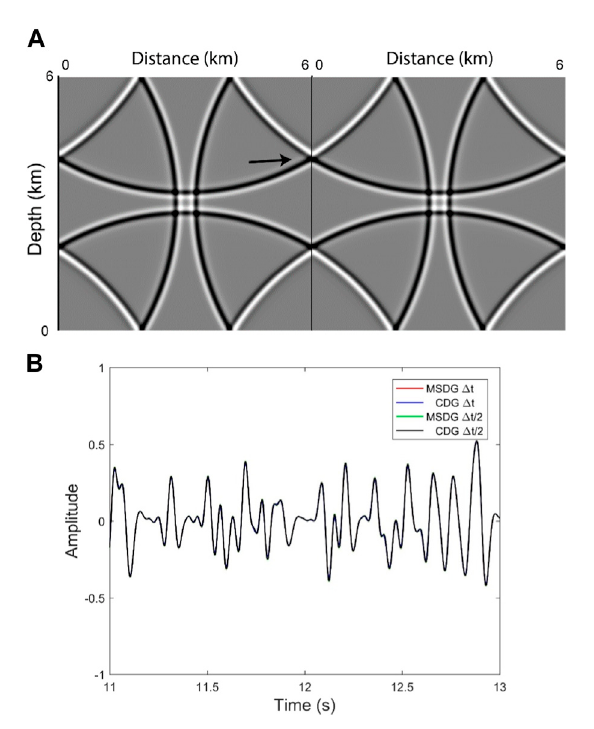
FIGURE 4 (A) Snapshotsofthewave fi eldsgeneratedbytheMSDGandCDG methods at t = 2 s, where the left part is generated by the MSDG methodandtherightpartisgeneratedbytheCDGmethod.Thearrow indicates that there is a slight phase shift. (B) Normalized waveforms within the time interval of [11 s, 13